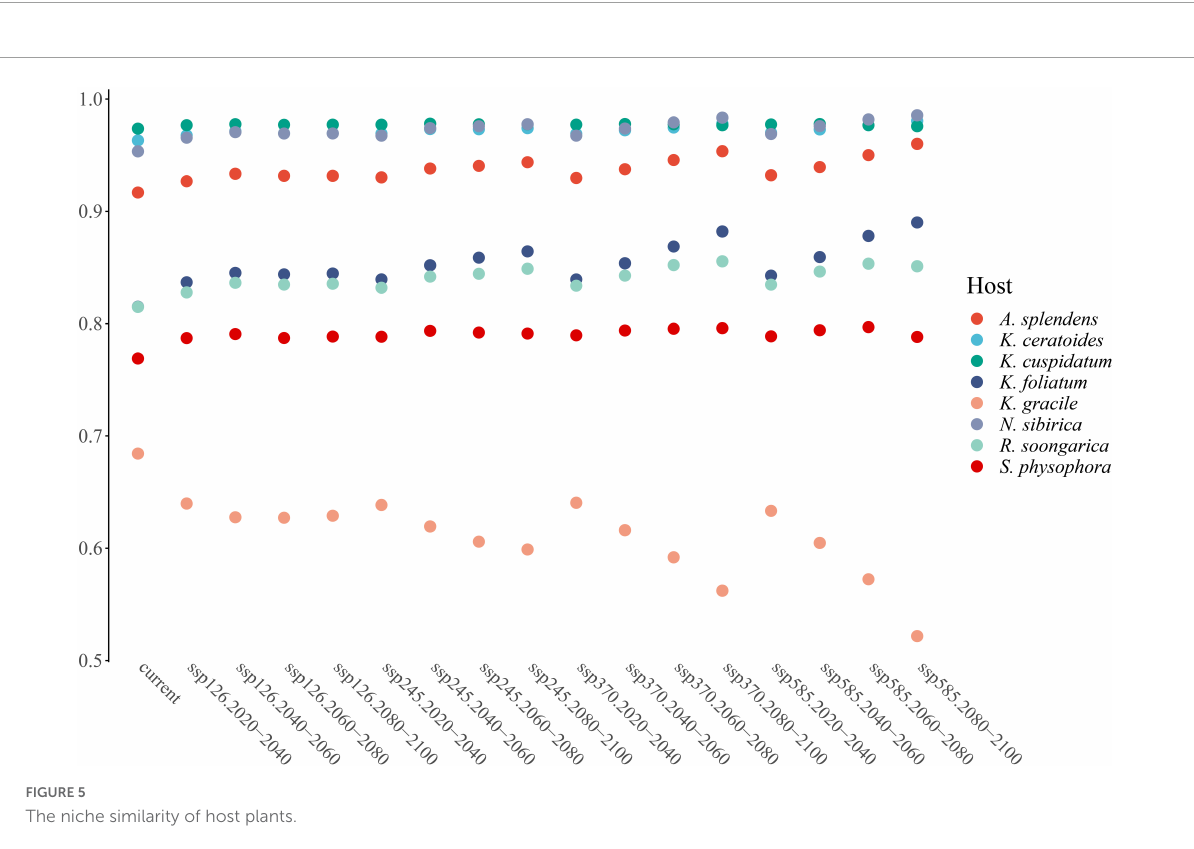
FIGURE5 The niche similarity of host